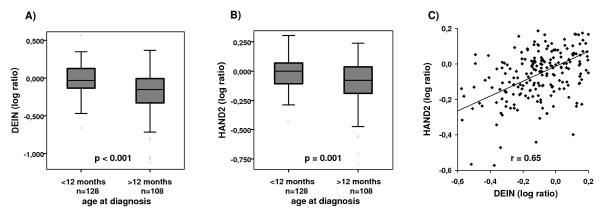
DEIN and HAND2 expression in 236 primary neuroblastomas as determined by microarray analysis. Relative expression levels of DEIN (A) and HAND2 (B) in neuroblastoma subsets according to age at diagnosis. Scatter Plot showing correlation of relative expression values for HAND2 and DEIN (C); r, Pearson's correlation coefficient.